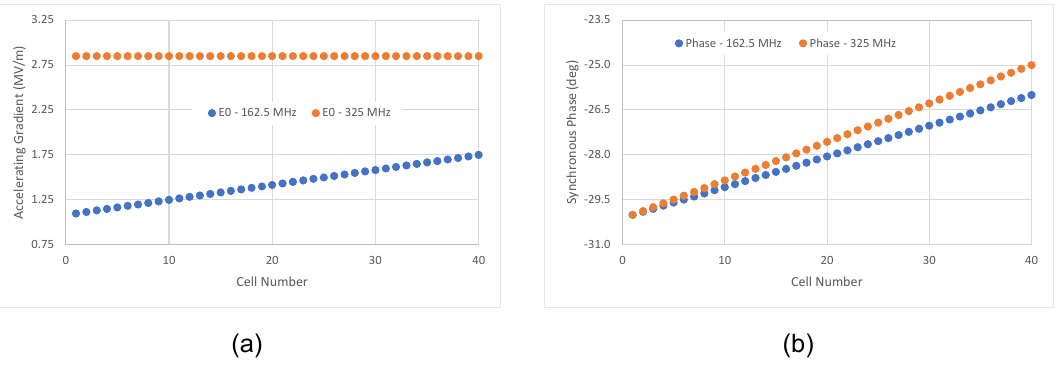
Figure 8. Accelerating gradients ( a ) and synchronous phases ( b ) of both DTL tanks. The longitudinal beam dynamics simulated with the TraceWin code [46] are shown in Figure 9. All macro particles are within the stable bunch widths in the whole DTLs, and no beam loss is found in the longitudinal phase space.